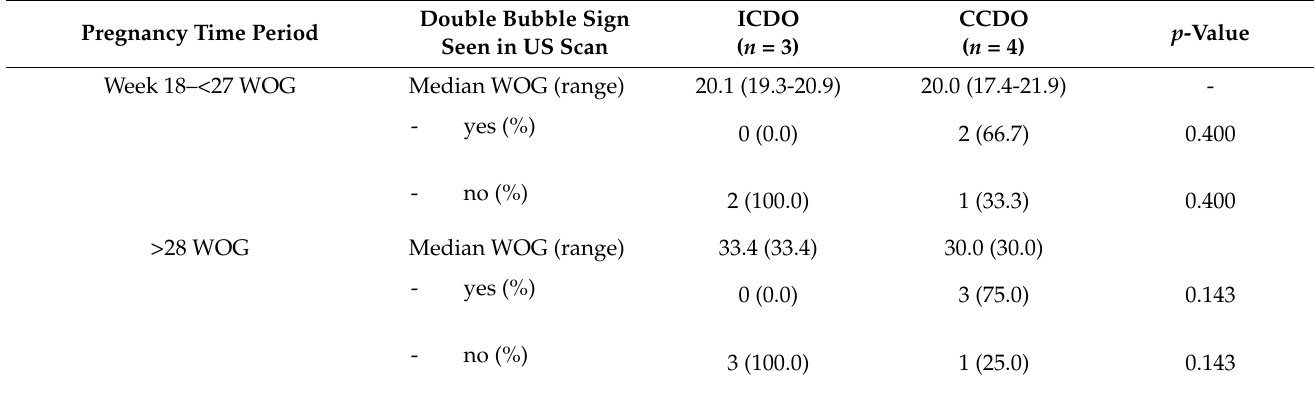
Table 5. Detection rate of the double bubble sign during ultrasound examinations conducted by specially certified DEGUM